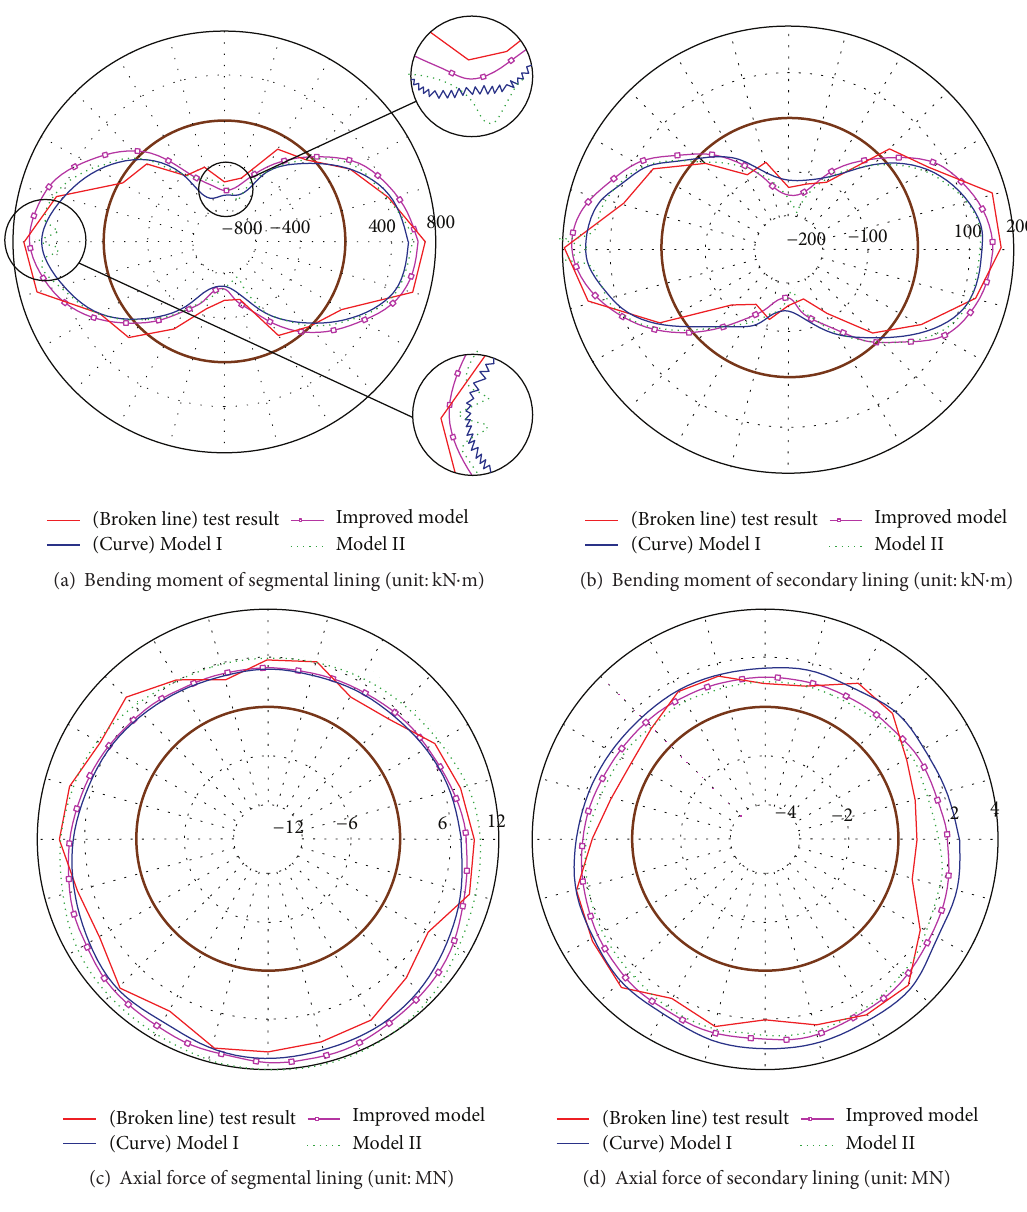
Figure 10: Diagrams for tested values and calculated values of internal forces in lining.